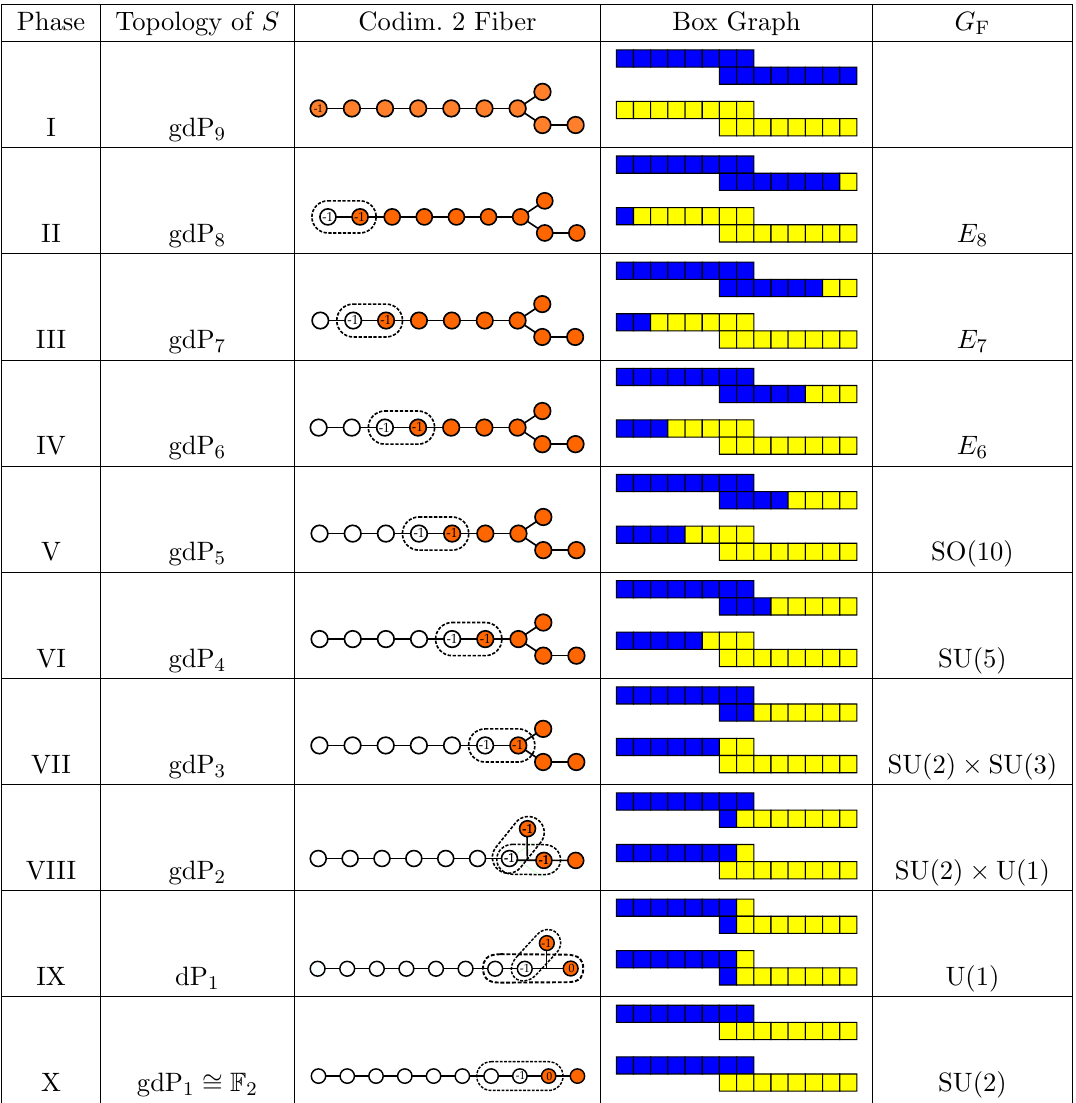
Table 6. Box graphs and codimension two (cid:12)bers corresponding to the rank one 5d SCFTs. The sur- face S with given topology, which in an M-theory realization would supply the SU(2) gauge theory description, contains the codimension two (cid:12)ber that is shown. Obtained in [2] from non-(cid:13)at resolu- tions, all curves have self-intersection (cid:0) 2 inside S , except when otherwise noted. The orange colored rational curves are those contained in the surface component S . The (cid:13)avor curves are the fully con- tained ( (cid:0) 2)-curves (colored and unlabeled). We furthermore list the box graph/Coulomb branch phase for the gauge theory description of SU(2) gauge (cid:2) SO(16) BG with matter in the ( 2 ; 16 ). The last column contains the enhanced (cid:13)avor symmetry G F of the 5d SCFT obtained from shrinking S .